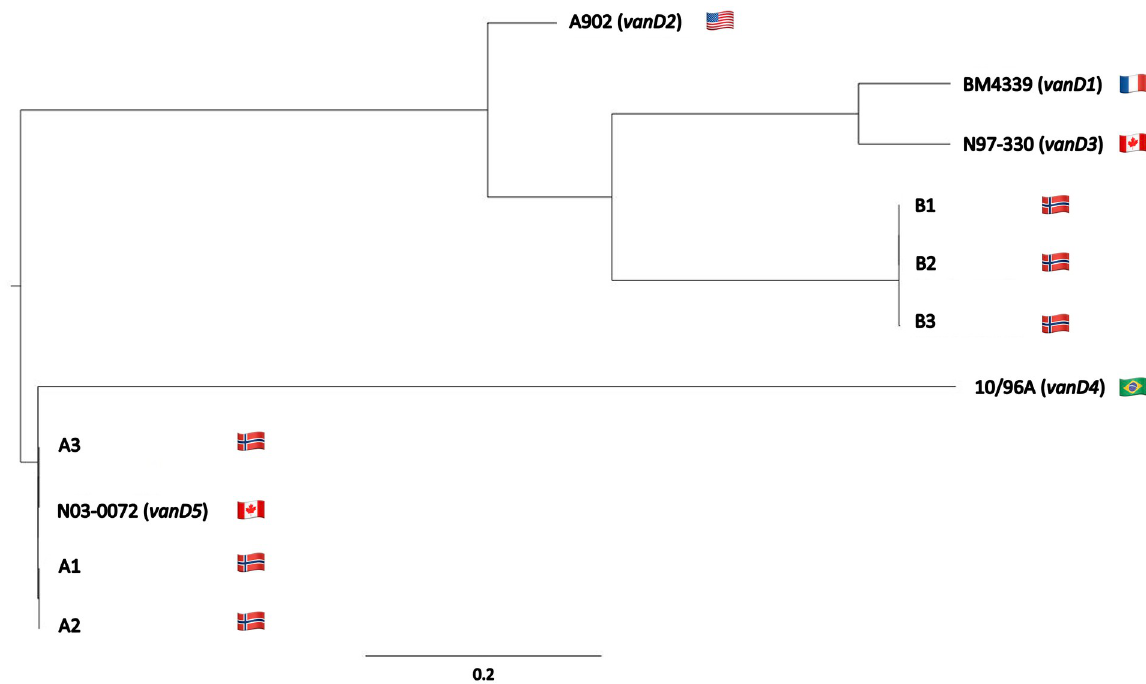
Fig 2. Phylogenetic SNP tree of the vanD gene clusters of the Norwegian and vanD1 — vanD5 subtype reference clusters retrieved from NCBI. Flags represent the countries that vanD -types were discovered in first. Case A strains clustered with vanD5 reference N03-0072 while case B strains clustered separately.